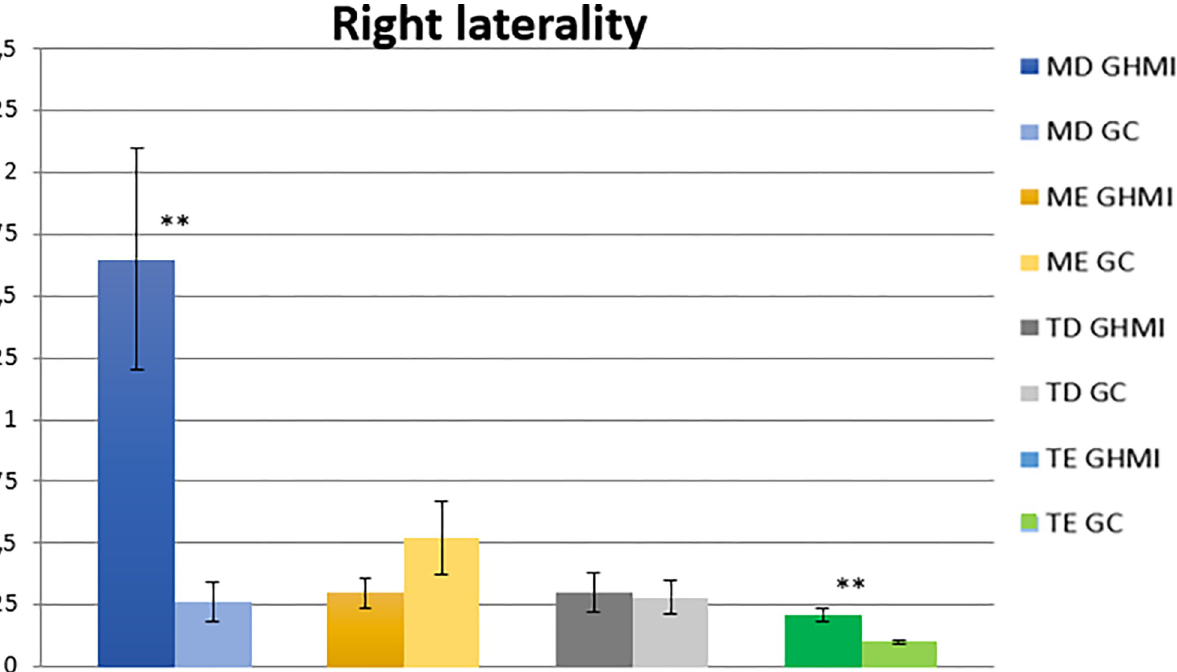
Fig 4. Normalized electromyographic means (RMS) in the right laterality